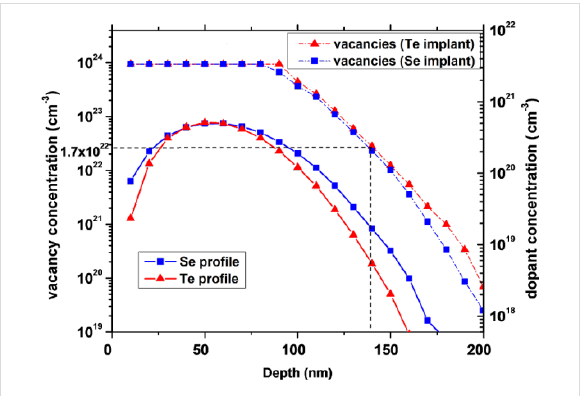
Figure 1: SRIM calculations of the implant distribution of Te (red) and Se (blue) atoms in Ge. The distributions of implanted ions are shown using straight lines on the right axis and the vacancies distributions are shown using dashed lines on the left